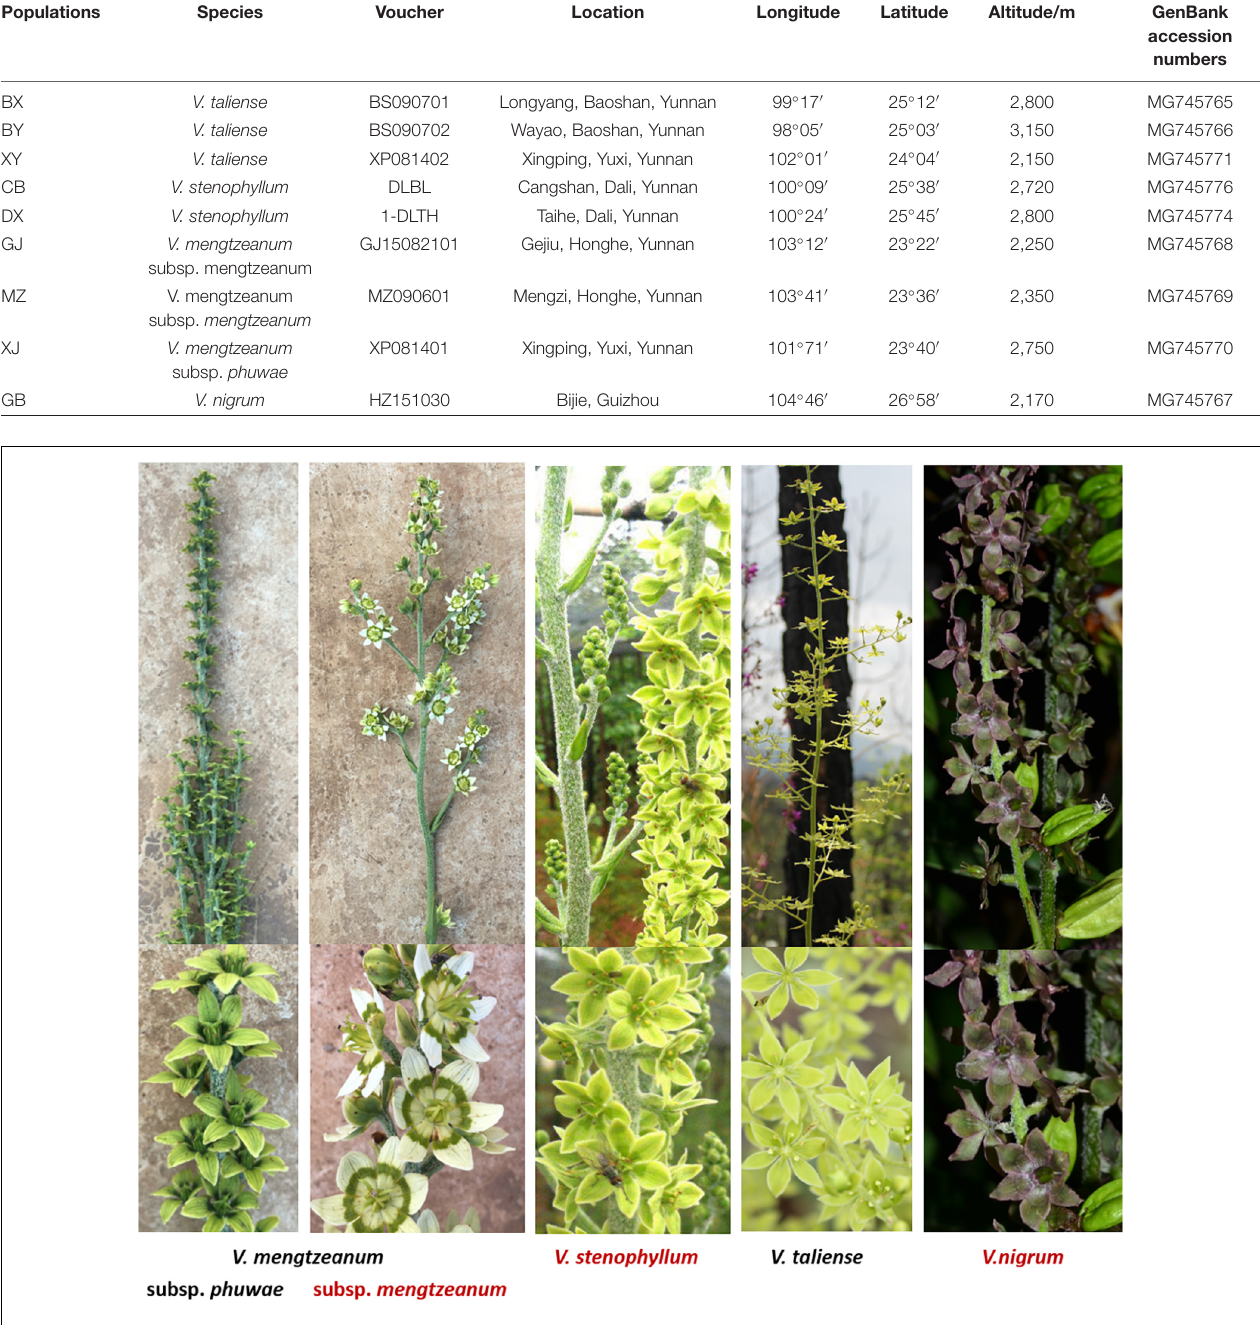
FIGURE 1 | Inflorescence of Pimacao origin